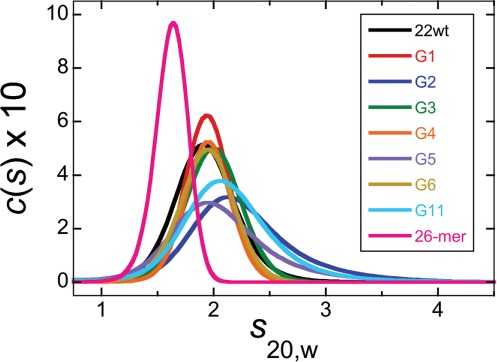
Sedimentation coefficient distributions for telomere sequence and single-stranded DNAs. Sedimentation velocity data were measured at 4°C and 40 000 rpm in 10 mM Tris–HCl (pH 8.0), 1 mM EDTA supplemented with 75 mM KCl and 5 mM MgCl2. DNA concentrations were ∼0.9 μM (A260 ∼0.25). Smooth curves are c(S) distributions calculated with the program Sedfit (30,35).